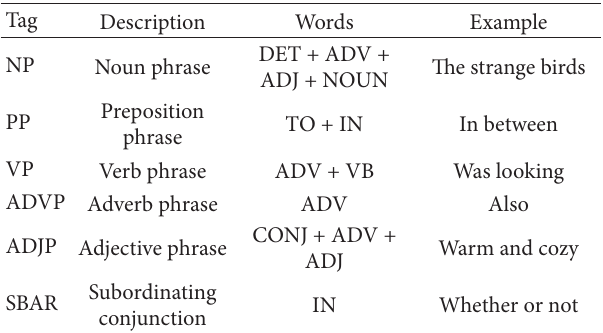
Table 2: The description of universal chunk